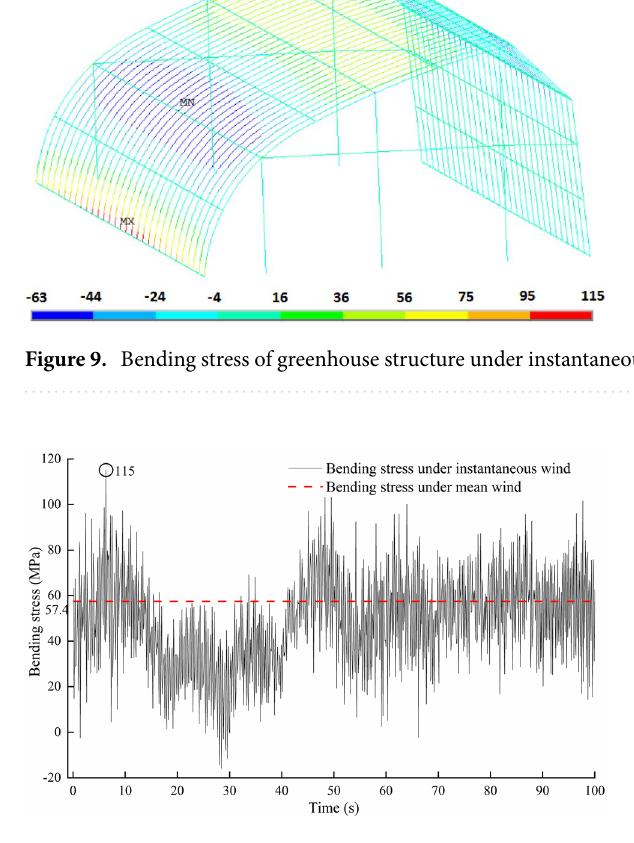
Figure 10. Stress time history of the element with maximum bending